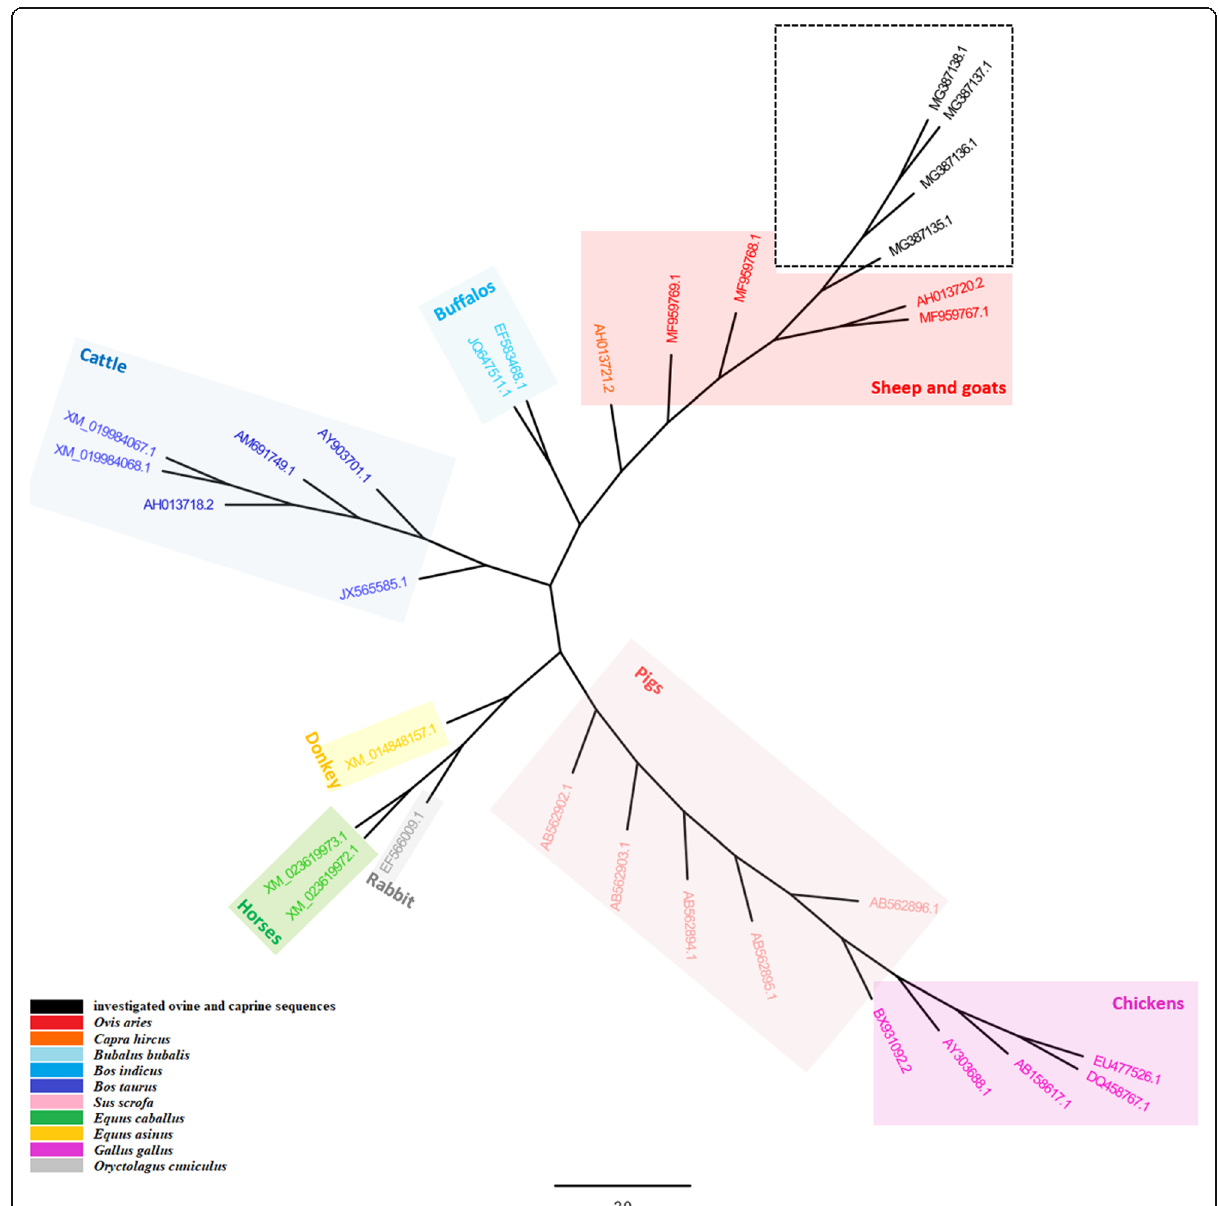
Fig. 2 A GHRL gene-based phylogenetic tree of the observed 262-bp SSCP banding patterns of Awassi and Karadi sheep and Shami and Iraqi Native goats with other livestocks. Both query variants were colored and highlighted in black, while other livestocks were colored appropriately. All the mentioned numbers referred to GenBank accession number of each reference species. The number “ 2.0 ” at the bottom of the tree referred to the degree of scale range amongst the tree-categorized